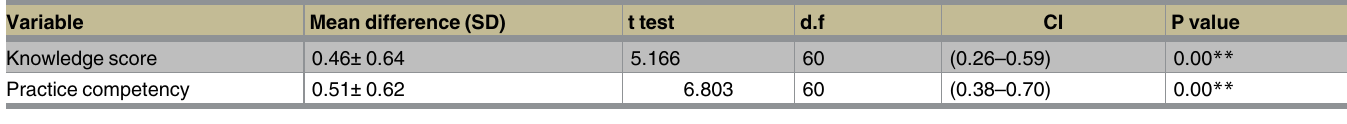
Table 3. Comparison of mean differences on knowledge and practical competency before and after the intervention in Hawassa Health Science College, 2015 (N = 61).